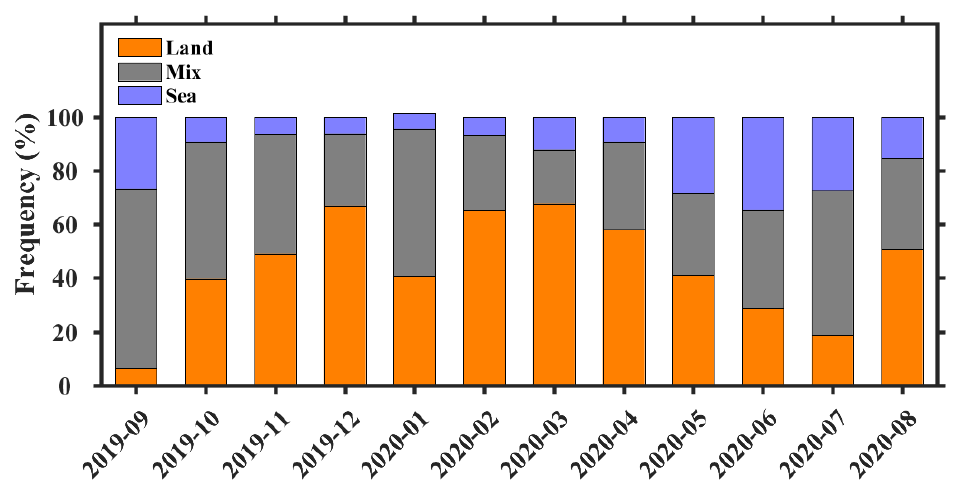
Figure 6. Percentage of different aerosol sources from September 2019 to August 2020 in Qingdao based on backward trajectory clustering.